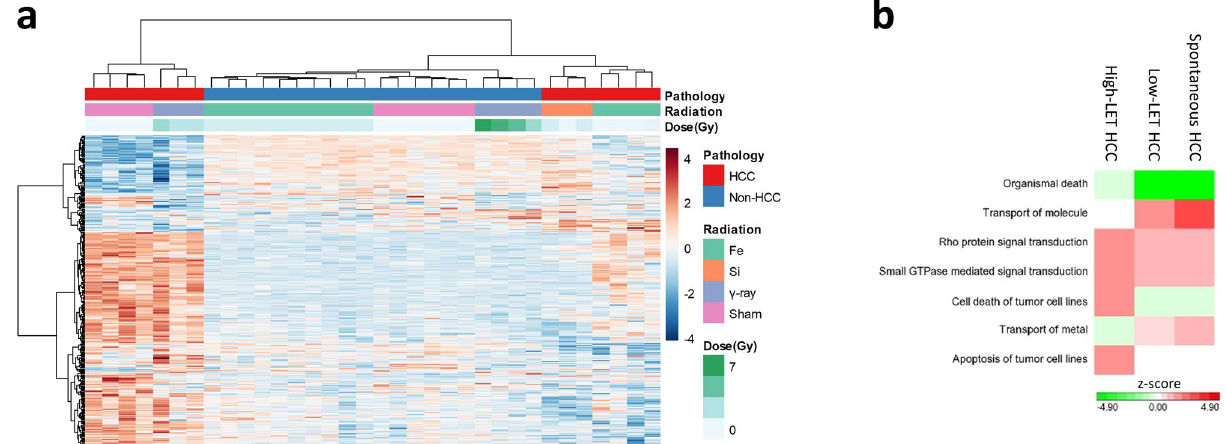
Figure 3. A gene set (mR-HCC) that discriminated mouse HCC induced by different radiation types. ( a ) Supervised clustering analysis using genes identified from ANOVA not only clustered HCC and non-HCC samples, they also separated un-irradiated and different radiation types in each group. ( b ) Gene functional analysis showed significantly enriched functional groups associated with the gene set. The heatmap was plotted with activation